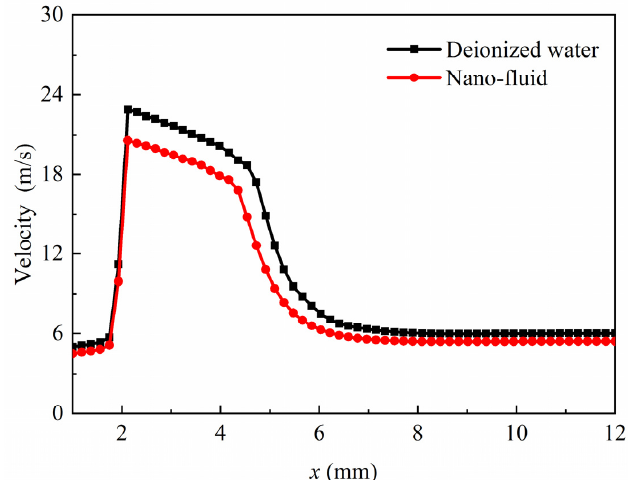
Figure 8. The velocity distributions at centerline on the symmetry plane.